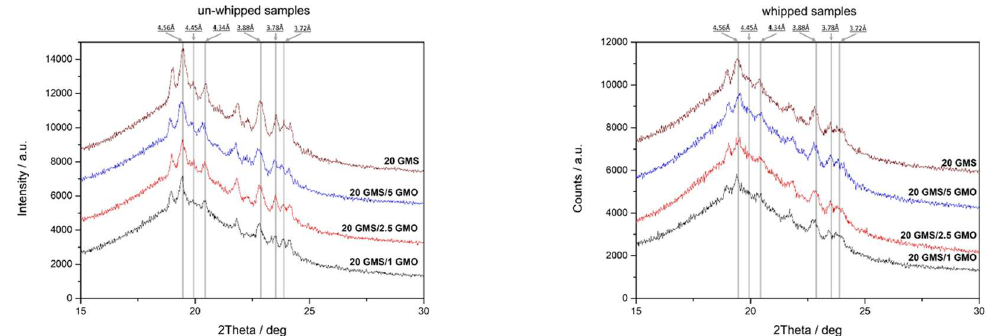
Figure 8. XRD patterns of whipped and un-whipped